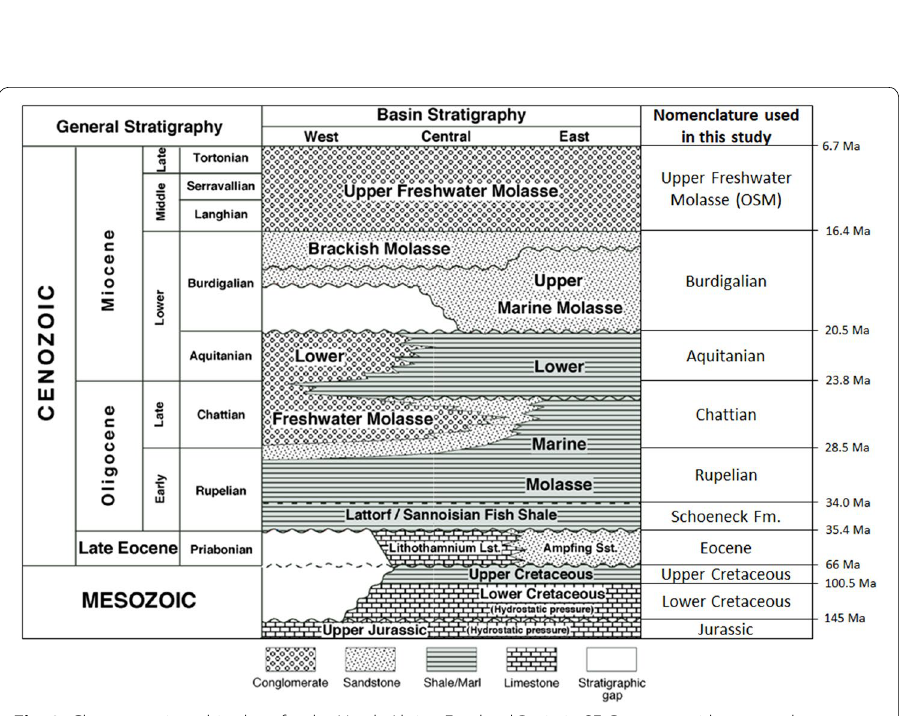
Fig. 2 Chronostratigraphic chart for the North Alpine Foreland Basin in SE Germany with nomenclature and geologic ages [after (Drews et al. 2018; Kuhlemann and Kempf 2002)]. Geologic ages for Late Miocene– Rupelian, Schoeneck–Eocene and Mesozoic from Kuhlemann and Kempf (2002), Zweigel (1998) and Cohen et al. (2013), respectively. The term Lattorf/Sannoisian is outdated and replaced in this study by the Schoeneck Formation (c.f. Janssen et al. 2018). However, the term is generally used in well tops of the used oil and gas wells and therefore also displayed in this figure for